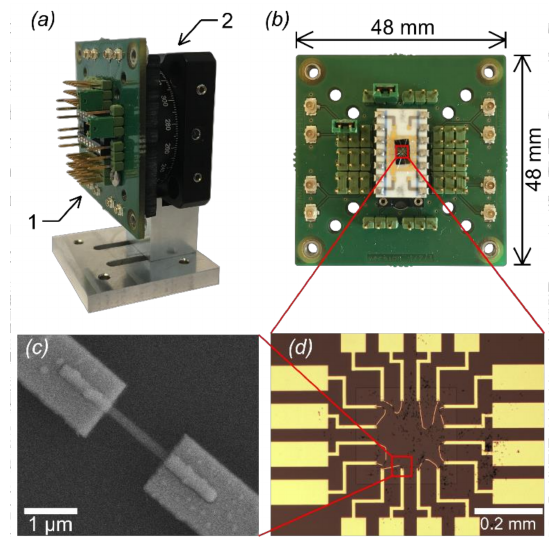
Figure 2. Nanowire device on the chip carrier and sample holder ( a ) The two main components of the sample holder are (1) the circuit board (green) and (2) the rotational mount (black). ( b ) The front side of the circuit board mounted with the 10 × 18 mm 14-pin chip carrier which has the nanowire device on the top. The circuit board consists of a 16-pin chip socket, vertical pins and U.FL terminals. This circuit board size is 48 × 48 mm. This side faces upstream towards the X-ray beam. Each slot of the chip socket is connected to a pin in a set of three vertical pins. By selecting pins, a particular nanowire device can be connected to the external equipment. ( c ) SEM image of the contacted single nanowire device. ( d ) Microscope image of eight nanowire devices on a SiN membrane window, seen as a lighter square in the center, surrounded by Au bonding pads which was attached on the chip carrier in ( b